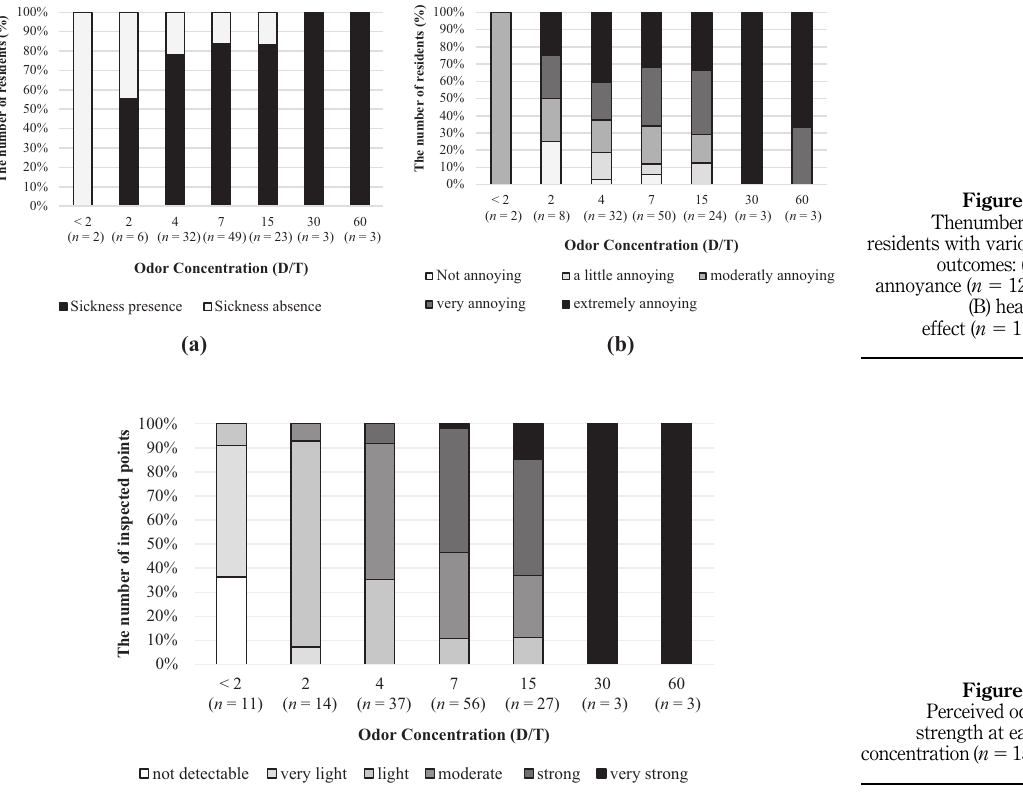
Figure 2. Thenumber of